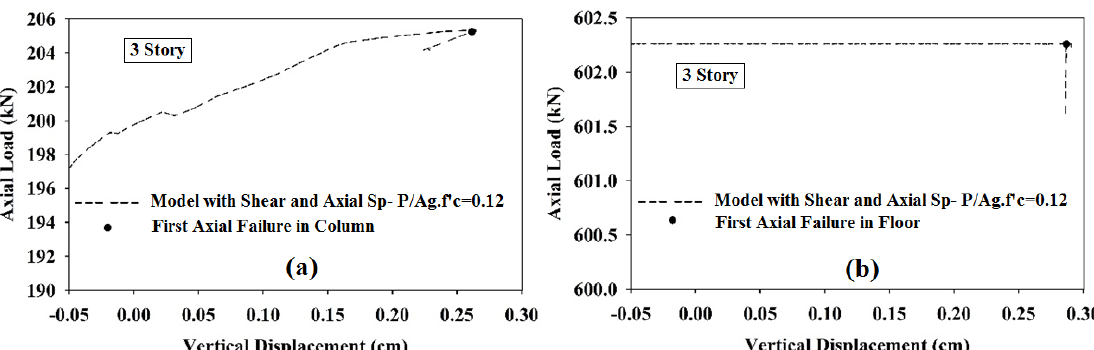
Fig. 9. Axial Load – Vertical Disp. plot due to non-linear pushover analysis in 3-Story model (a) the first axial failure in the column and (b) the first axial failure in the